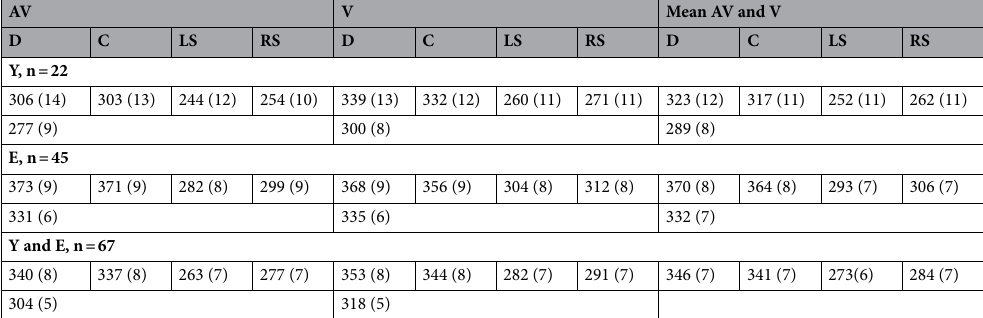
Table 1. Latency means and standard errors. Means and sd in ms of the latencies, by group age, movements and targets modalities. Y for the young group. E for the elderly group. A for auditory targets, AV for audiovisual targets. D for divergence, C for convergence, LS for left saccades, RS for right